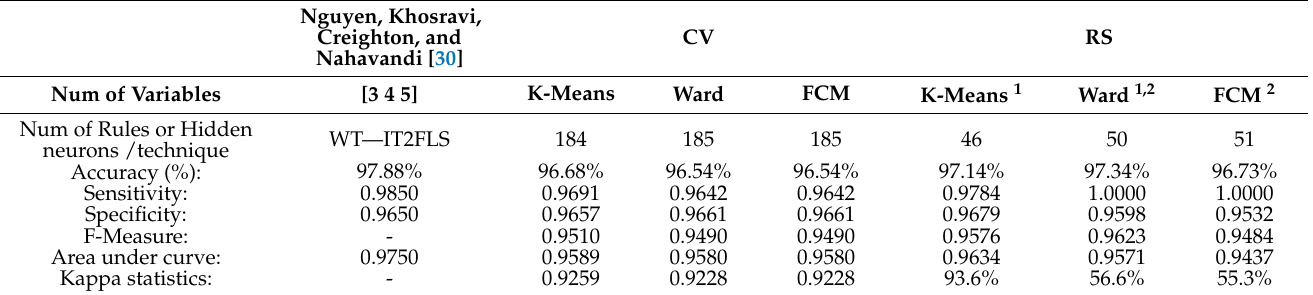
Table 6. Performance metrics obtained with our proposed framework compared with results obtained by Nguyen, Khosravi, Creighton, and Nahavandi [30].